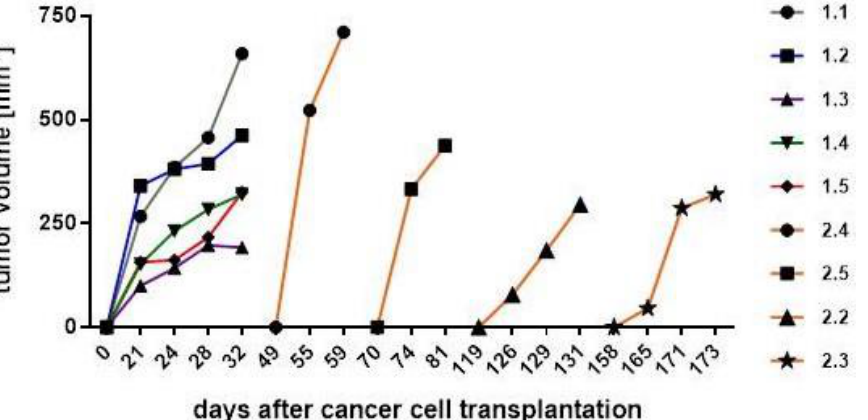
Figure 4. After tumor cell injection of MDA-MB-231 (mouse #1.1 to #1.5) and MDA-hyb5 (mouse #2.2 to #2.5) into the NODscid mice, the tumors first became detectable at the indicated time points. Continuous tumor growth and detection of appropriate sizes were measured using a digital caliper. Progressive tumor volumes relative to the corresponding time points were calculated with the longitudinal diameter (length) and the transverse diameter (width) in the modified ellipsoidal formula: volume = π /6 × width × (length) 2 , as previously reported